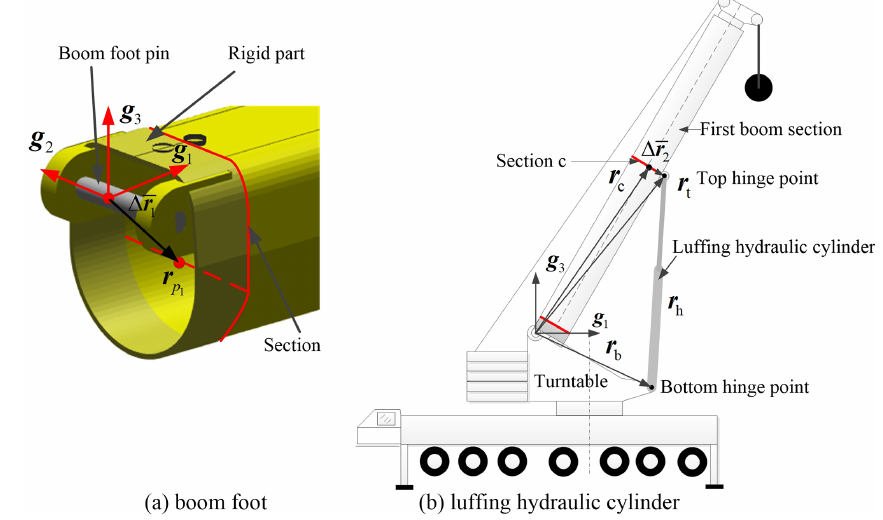
Figure 8. Foot pin and luffing hydraulic cylinder of a telescopic boom.